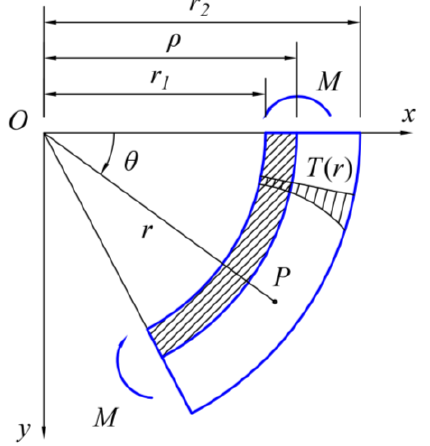
Figure 2. The bimodular curved beam under bending moment and thermal load.